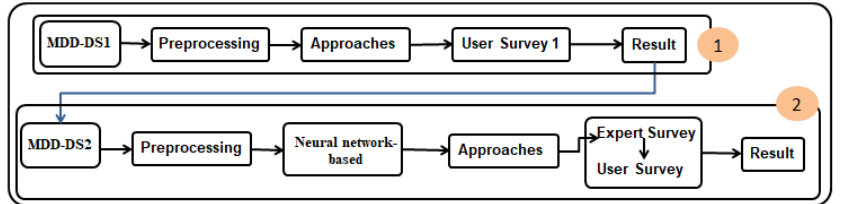
Figure 2. More details on description of the proposed model definition and